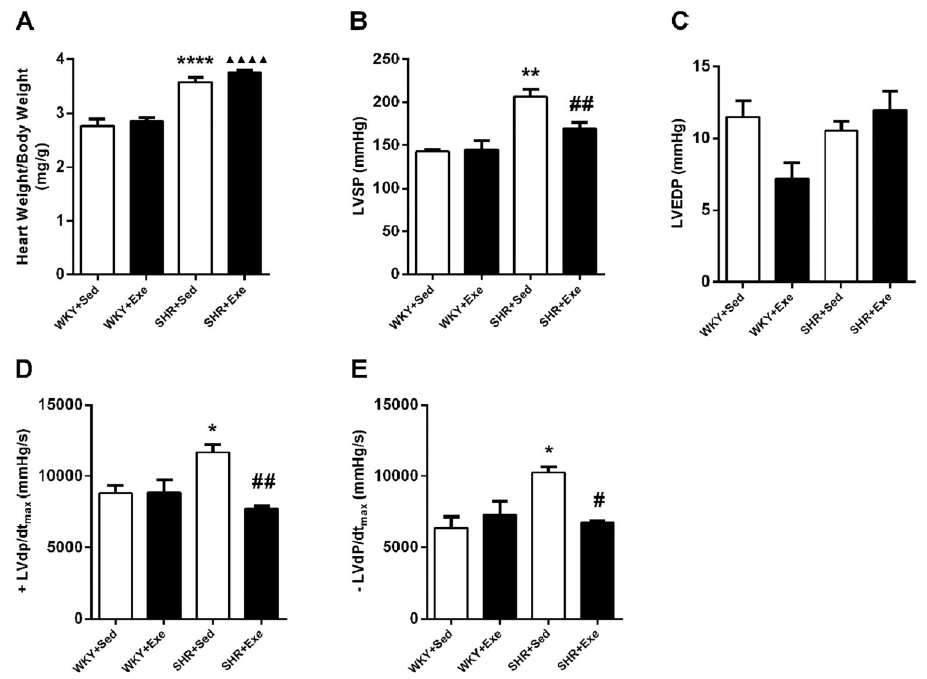
Figure 1. Moderate-intensity exercise improved cardiac function in spontaneous hypertensive rats (SHRs). Eight-week-old male SHRs and age-matched male Wistar-Kyoto (WKY) rats were randomly assigned to exercise training (Exe) or kept sedentary (Sed) for 16 weeks. The graph shows changes of heart weight/body weight ratio ( A ) and indexes of cardiac function including LVSP ( B ), LVEDP ( C ), (cid:1) LVdP/dt + Sed, WKY + Exe, SHR + Sed and SHR + Exe groups. Data are reported as + LVdP/dt max ( D ), and max ( E ) measured in WKY means ± SE (n=4 for A and n=3 for B – E ). *P o 0.05, **P o 0.01, ****P o 0.0001 vs WKY + Sed group; mmmm P o 0.0001 vs WKY + Exe group; # P o 0.05, ## P o 0.01, vs SHR + Sed group (ANOVA). LVSP: left ventricular systolic pressure; LVEDP: left ventricular end diastolic pressure; ± LVdP/dt max : positive or negative instantaneous fi rst derivation of left ventricle